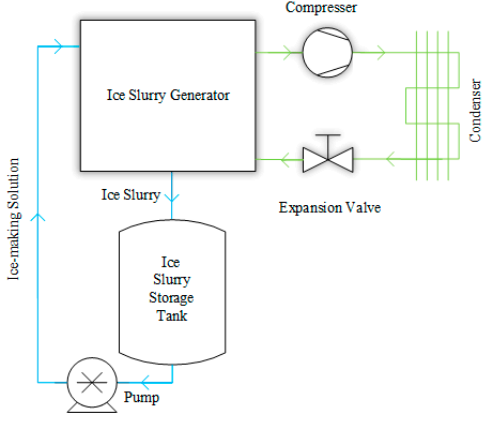
Figure 1. Schematic diagram of experimental apparatus. Table 1. The detail description of scraping